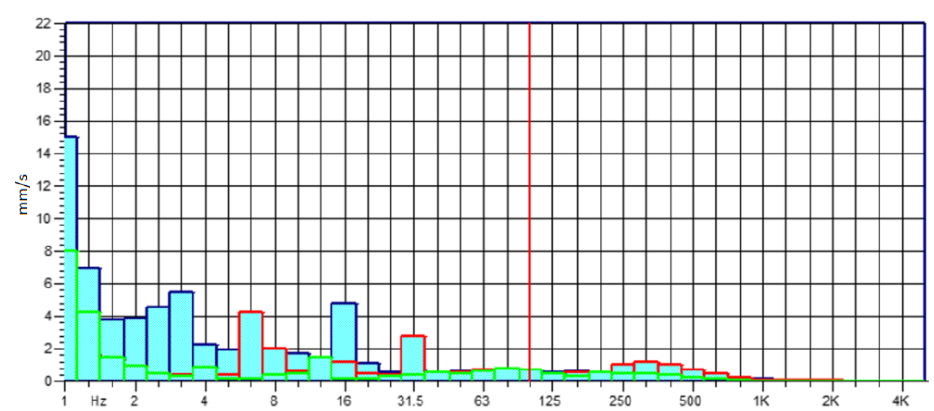
Figure 6. Frequency spectrum for all tractors at 600 rpm — Fiat 55L.